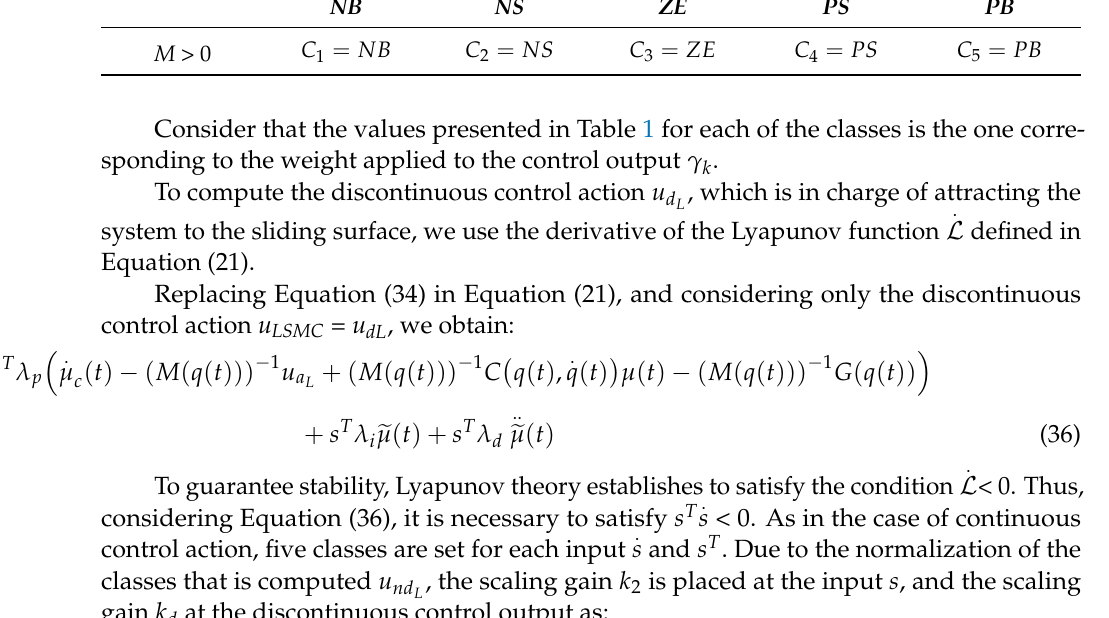
Table 1. Rule table of LSMC for